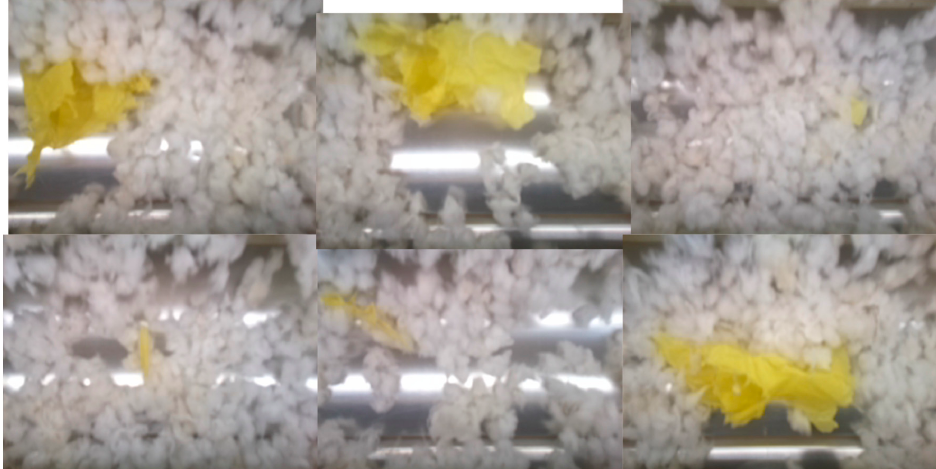
Figure 3. Plastic contamination images, captured by the prototype camera system, as deployed in a commercial cotton gin.